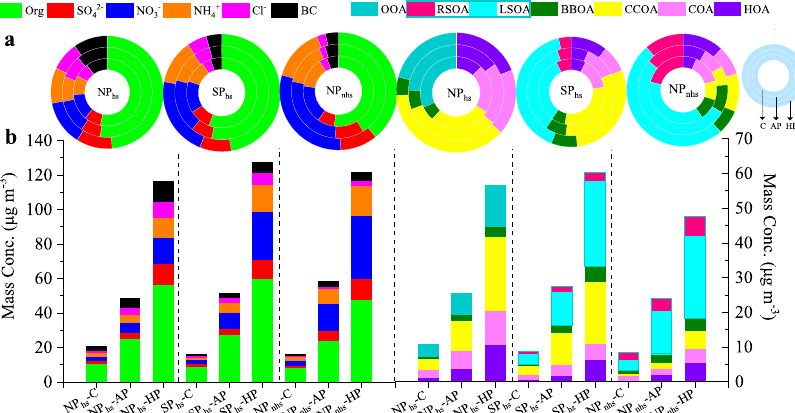
Fig. 5 Variations of PM 1 species and OA factors under different pollution stages. a Relative contributions and b average mass concentrations of PM 1 species and OA factors on clean days (C), average-pollution days (AP), and heavy-pollution days (HP) during the NP hs , SP hs , and NP nhs (As shown in the doughnut plot in the upper right corner, the innermost circle of this plot represents the clean days, the middle circle represents the average-pollution days, and the outermost circle represents the heavy-pollution